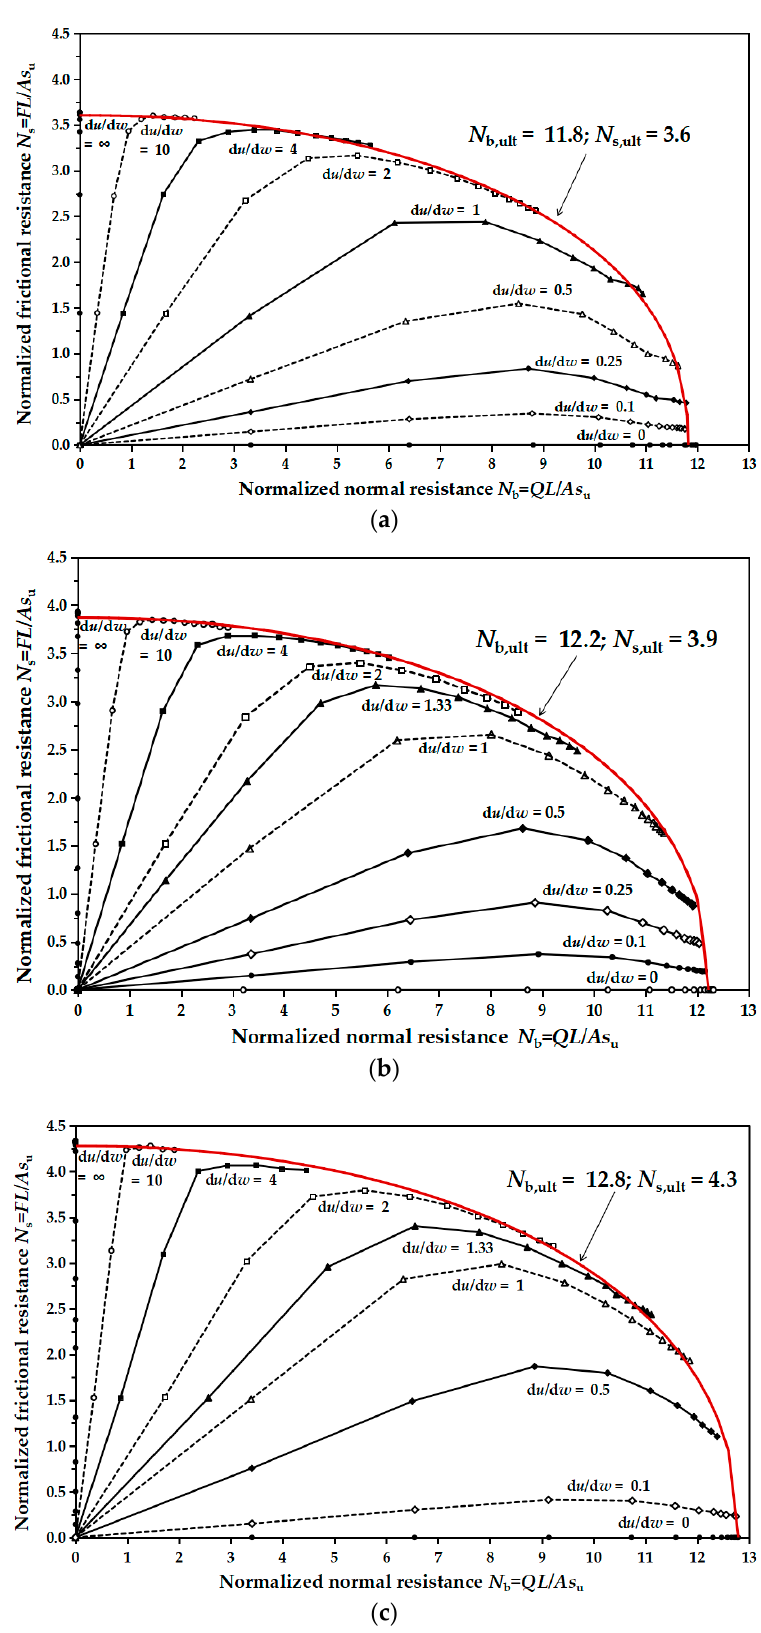
Figure 8. Yield envelope for chain segment under combined loading: ( a ) α = 0.3; ( b ) α = 0.5; ( c ) α = 1.0.